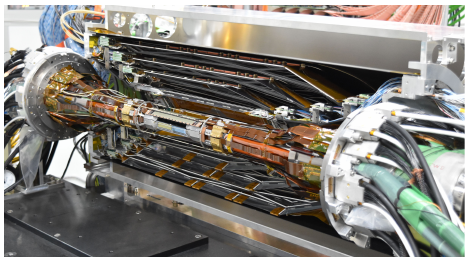
Figure 1. A half-shell of the vertex detector during installation. All VXD layers are exposed.